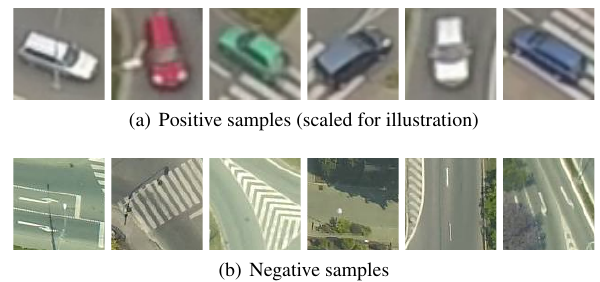
Figure 2. Examples of samples used to train vehicle